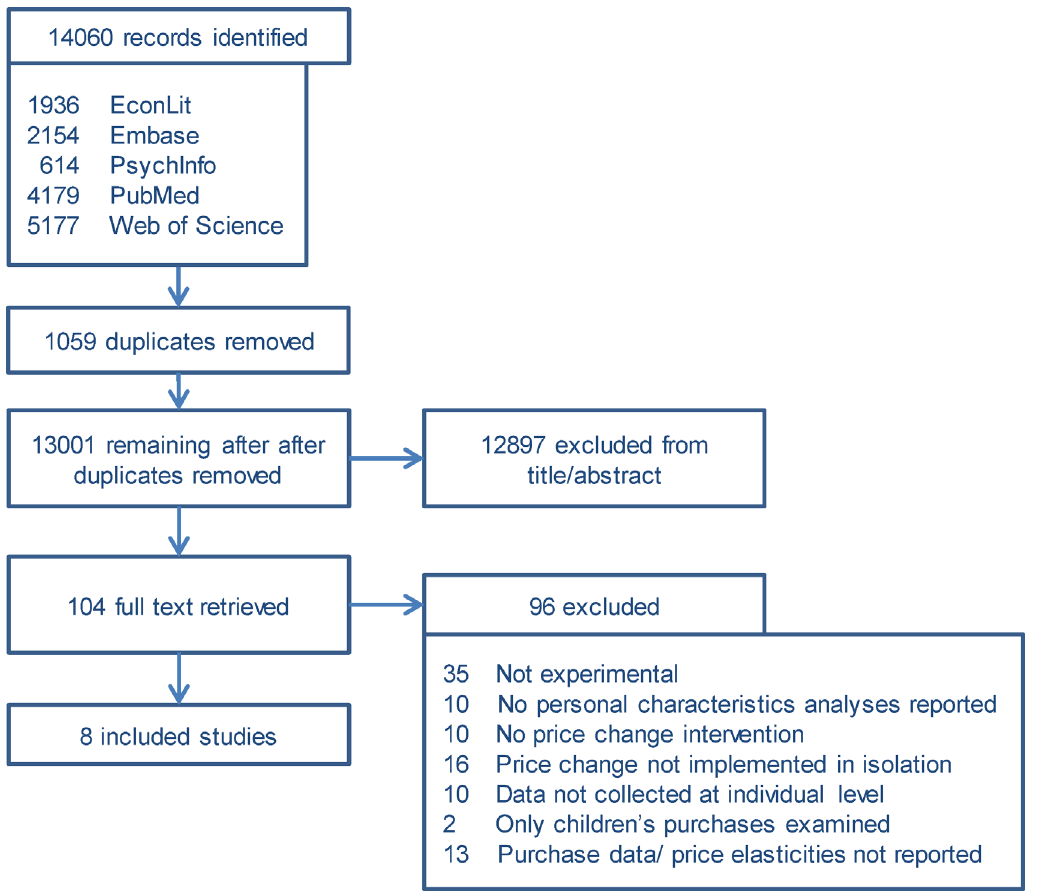
Fig 1. PRISMA flow